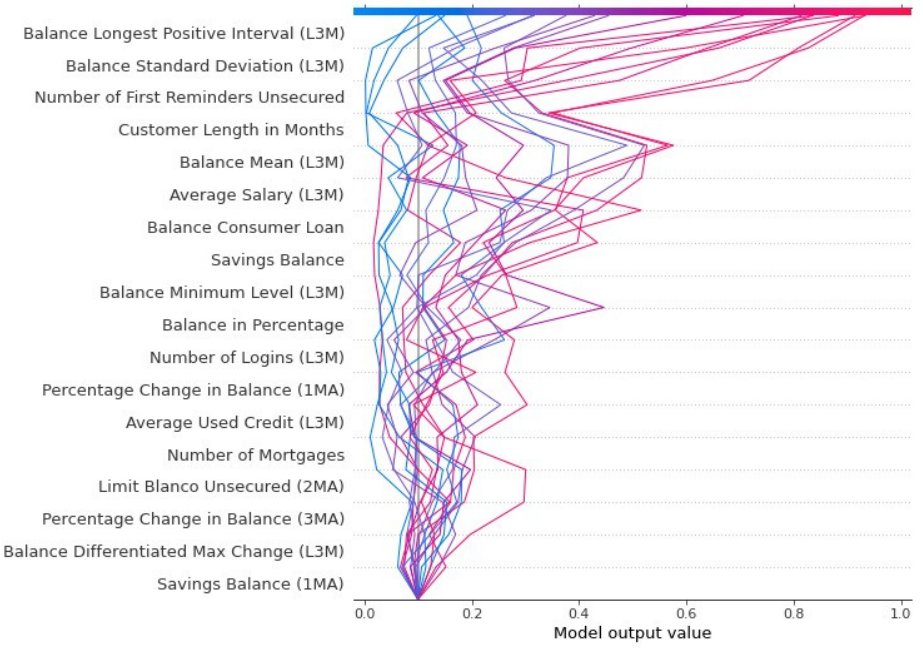
Figure 12. Decision plot for 20 defaulting observations correctly classified by the LightGBM model but wrongly classified by the LR model. Each line represents one customer. The plot is read bottom-up, starting with the chosen intercept and adding feature effects until each observation’s final prediction is reached. Features are ordered based on importance, in descending order.